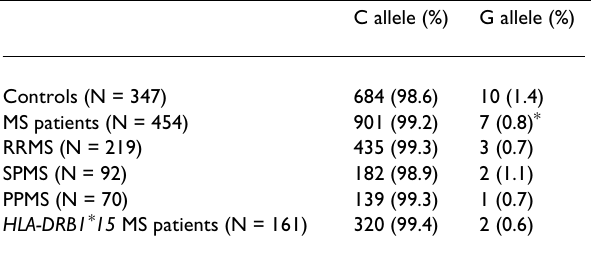
Table 1: Allele frequency of the 77C → G transition in PTPRC. Ho- mozygosity was not observed. 1.91 and of RRMS+SPMS 3.9 ± 2.25 [5]. C allele (%) Polymerase chain reaction (PCR) of exon 4 of PTPRC was carried out in a final volume of 12.5 µ l with 50 ng of DNA,